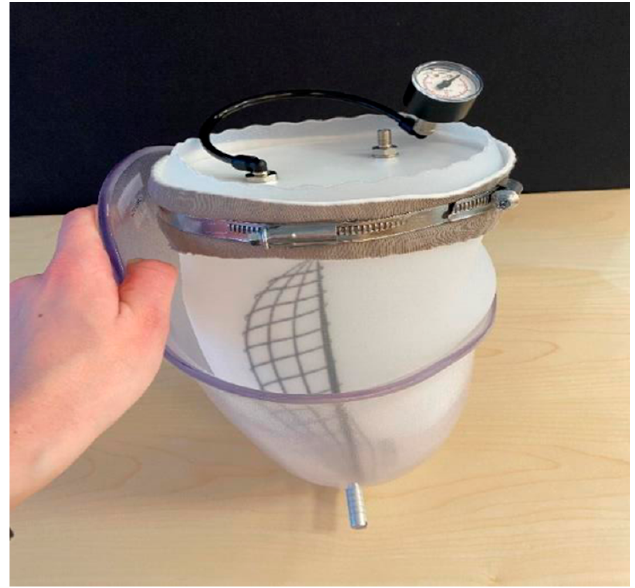
Figure 14. The liner balloon with a top plate.